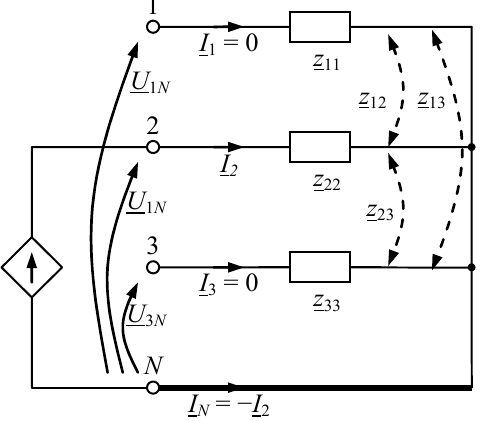
Figure 4. Electric circuit model of high-current busduct with current I i in a closed loop i-N and impedances Z ii and Z ij .